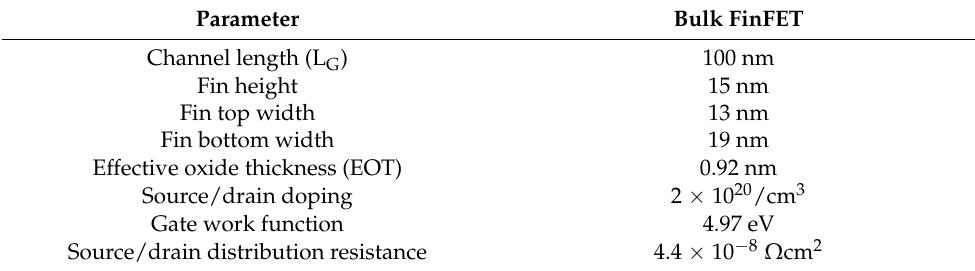
Table 1. Key device parameters used for TCAD simulation.